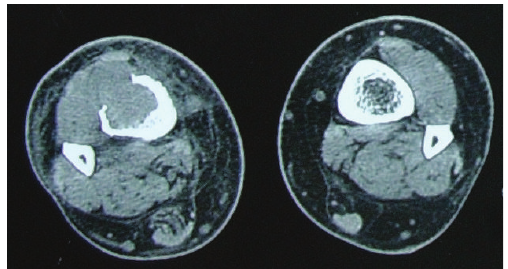
Figure 2: CT-scan of the tibia showing an intramedullar mass which destructs the cortical bone and spreads into the adjacent soft tissues.